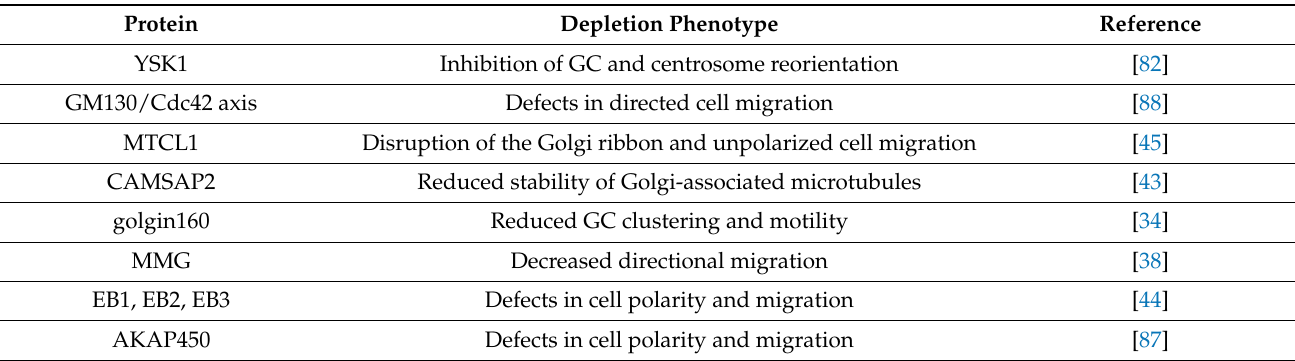
Table 1. Golgi-associated proteins involved in cell polarization and